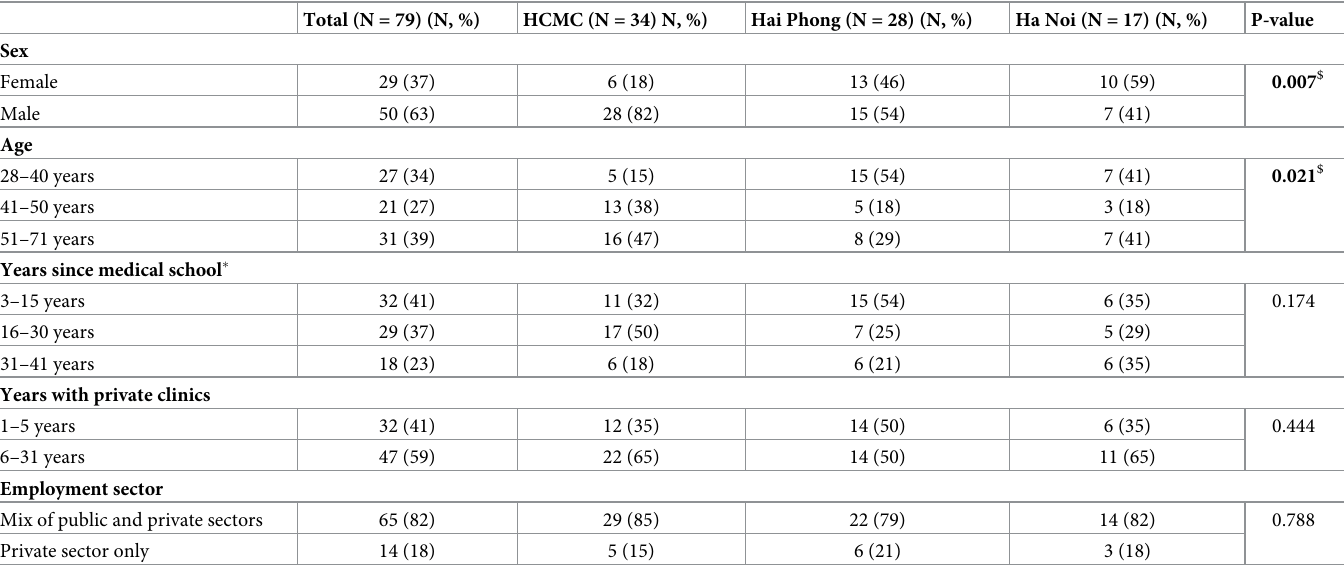
� Percentages may not total 100 due to rounding.